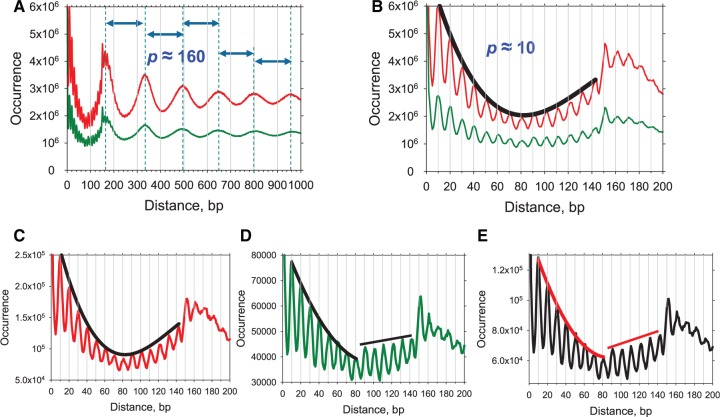
DAC function for nucleosomes in the control (red) and 3AT-treated (green) cells. (A and B) General and detailed views of the function for all NCP sequences 147–152 bp in length. The positions of the peaks in A are denoted by dashed lines, separated by ∼160 bp. A continuous envelope curve in B passes through the peaks of the profile for the control set. The envelope curve for the 3AT set is omitted for clarity. (C and D) Detailed views of the auto-correlation function for NCP sequences from 234 genes induced by 3AT (±200 bp). The envelope curve is continuous for the control set (C), but not for the 3AT set (D), in which a sharp increase in the profile of the auto-correlation function occurs at 80–90 bp. (E) Detailed view of the cross-correlation function for nucleosomes in the control and 3AT sets (see ‘Methods’ section). Envelope curves are shown as in D.